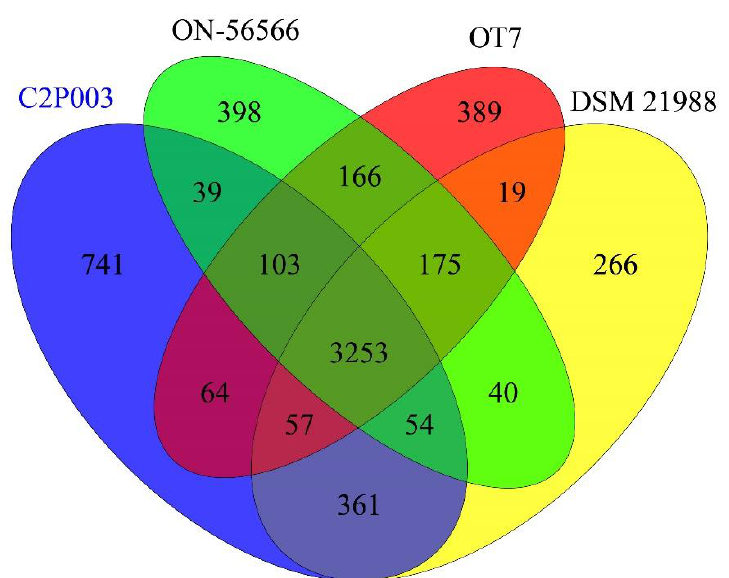
Figure 3. Venn diagram showing orthologous genes between the genomes of A. altamirensis C2P003, DSM 21988, ON-56566 and OT7. Table 2. Summary of protein-coding genes involved in host colonization and stress adaptation in the genome of A. altamirensis C2P003 and corresponding genes in the genomes of DSM 21988 and ON-56566.